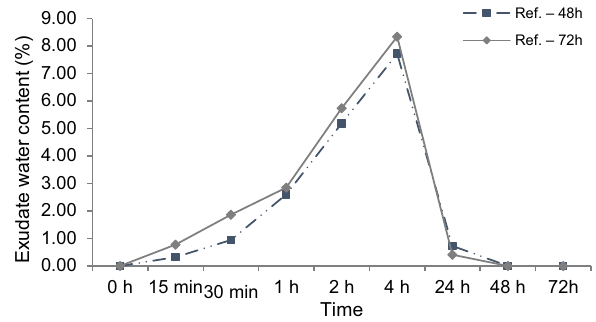
Figure 10: Water released by exudation in mortars for 48 and 72